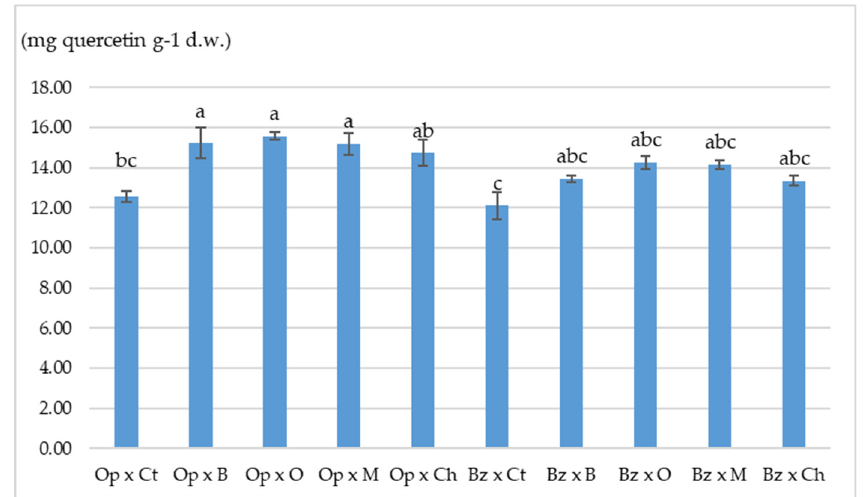
Figure 2. Total phenolics content in basil leaves, as affected by the interaction between cultivar and fertilization. Opal (Op); De Buzau (Bz); control (Ct); biosolids (B); organic (O); microorganisms (M); chemical (Ch). Values associated with different letters are significantly different according to Tukey’s test at p < 0.05.